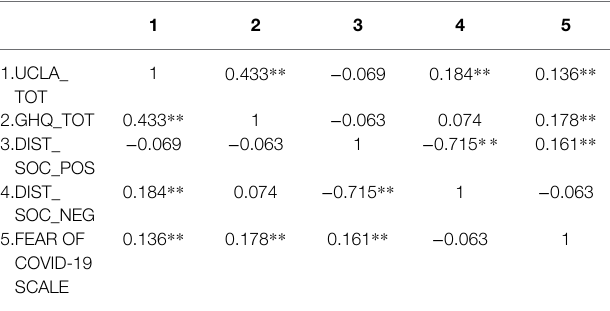
TABLE 9 | Correlations between the constructs investigated. TABLE 10 | Regression model: General health (GHQ-12) as dependent